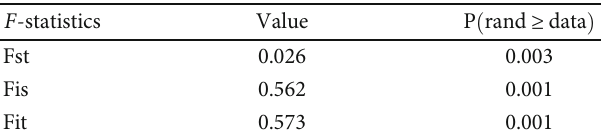
Where df: degrees of freedom; SS: sum of squares and MS: mean squares. Table 4: F -statistics values of populations collected from di ff erent region.